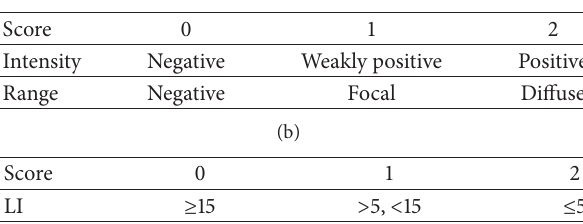
Table 1: (a) LMP2 score. (b) Ki-67